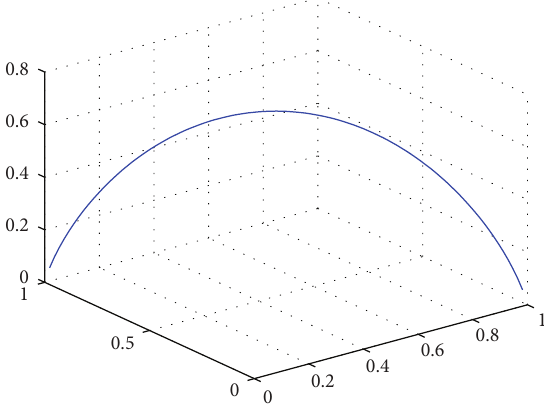
Figure 1: The relationship between the assignment of element and entropy.